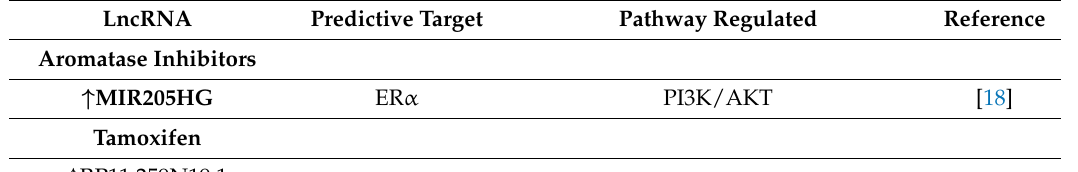
Table 1. Long non-coding RNAs associated with resistance to systemic